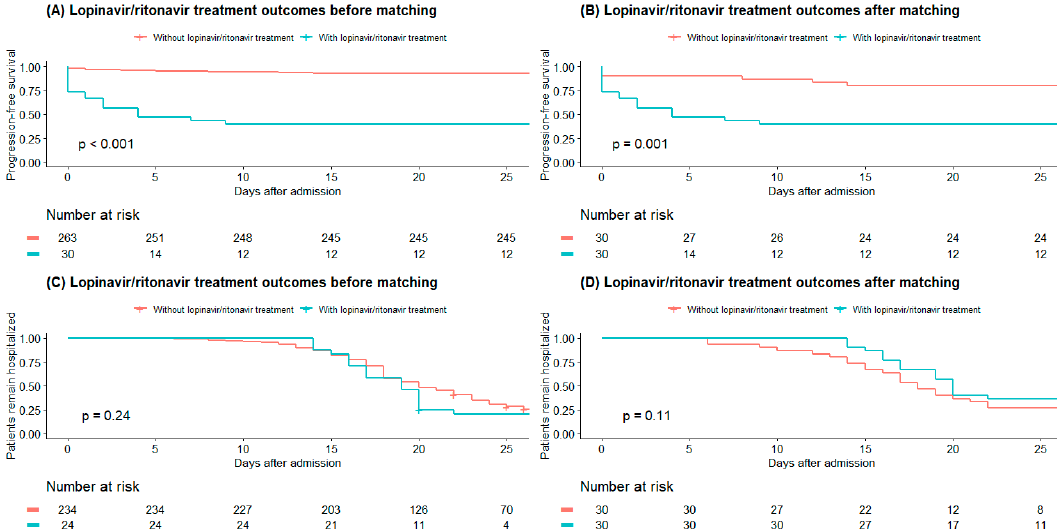
Figure 2. Kaplan–Meier survival analysis of progression-free survival ( A , B ) and proportion of patients requiring hospitalization ( C , D ) according to lopinavir/ritonavir treatment for patients with COVID-19 before and after propensity-score matching Figure legend: Patients treated with lopinavir/ritonavir group showed significantly lower progression-free survival than the without lopinavir/ritonavir group before and after propensity-score matching. but there was no statistical difference in discharge proportion between the two groups.